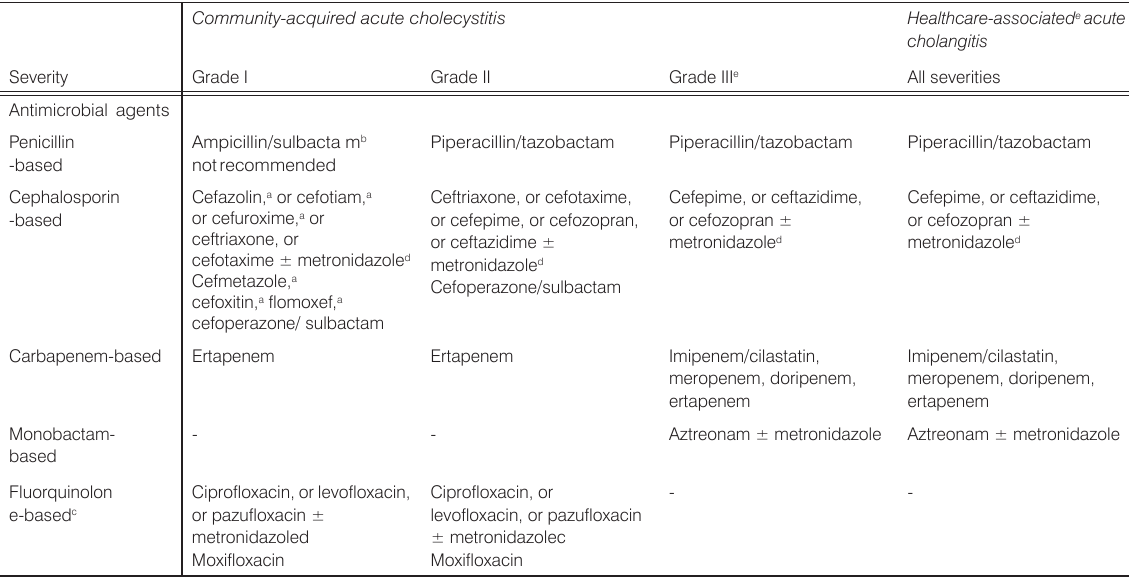
Table 1. TG13 Antimicrobial Recommendation for Acute Cholecystitis [ 30